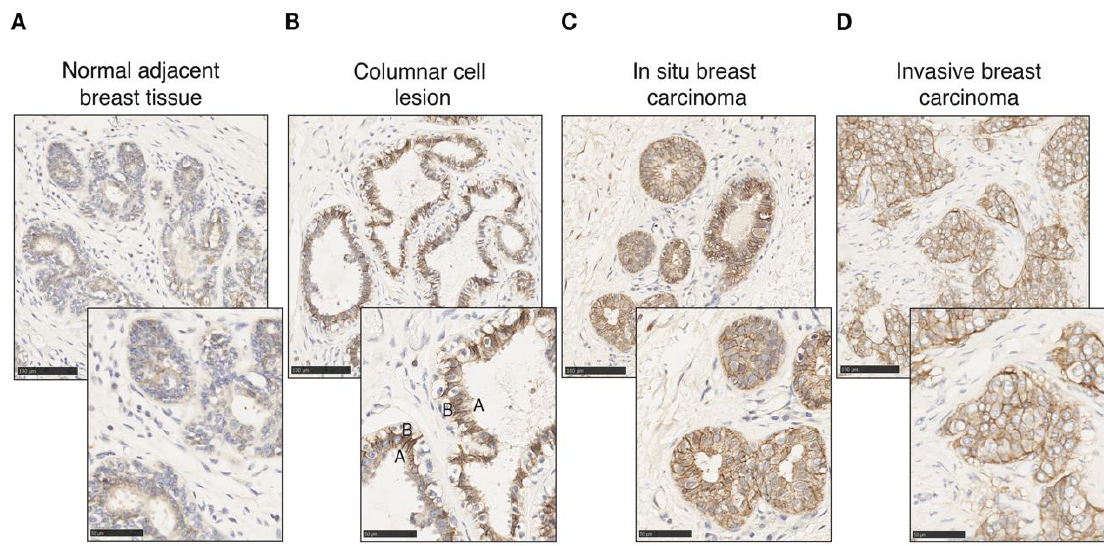
Figure 5. CAXII expression is increased in tumoral epithelial cells with loss of polarity. CAXII staining (in brown) of normal adjacent mammary tissue ( A ), columnar cell lesion ( B ), in situ breast ductal carcinoma ( C ) and invasive breast ductal carcinoma ( D ) at 20× and 40× magnification. The apical (A) and basal (B) poles of a luminal cell are labeled. 3.6. Levels of CAXII Correlate with Those of ERα, GATA3 and FOXA1 in Breast Tumor Arrays